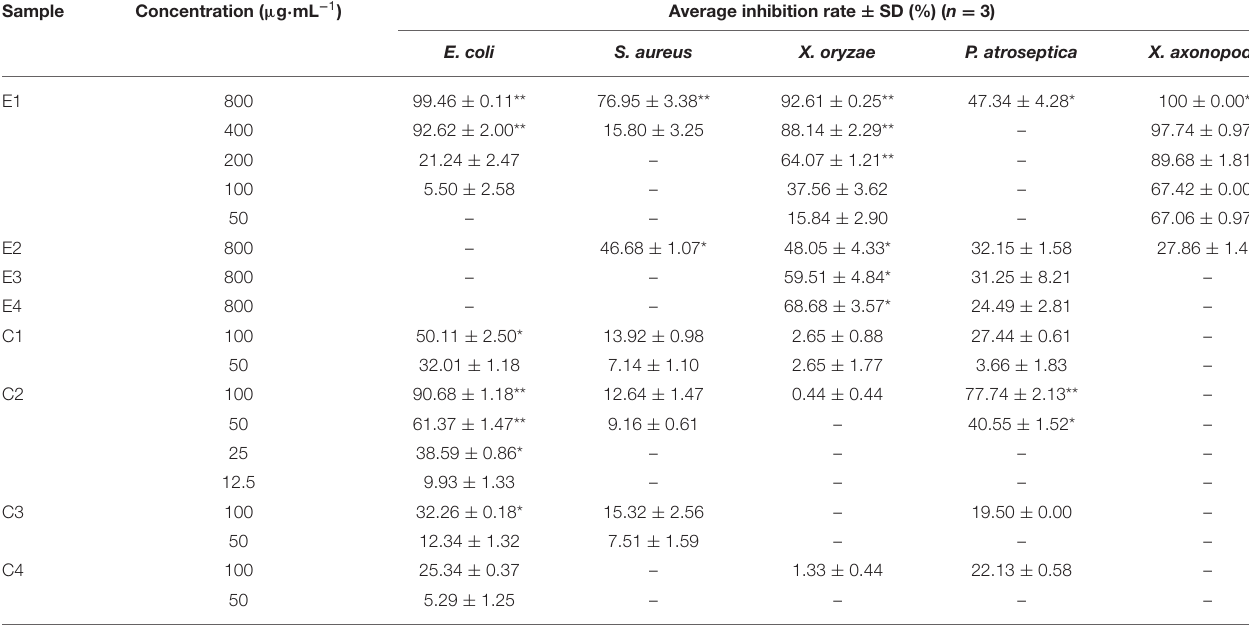
E1, The methanol extract of seed; E2, The petroleum ether extract of seed; E3, The methanol extract of the aerial parts; E4, The petroleum ether extract of the aerial parts; C1, Harmine; C2, Harmaline; C3, Vasicine; C4, Vasicinone. * P < 0.05, ** P < 0.01 compared with the control group.